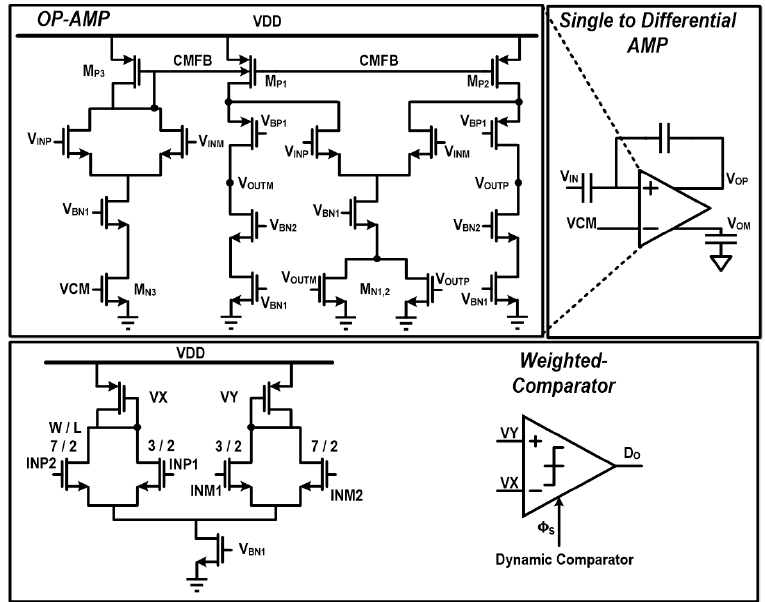
Figure 5. Weighted-comparator and single-to-differential amplifier circuits.